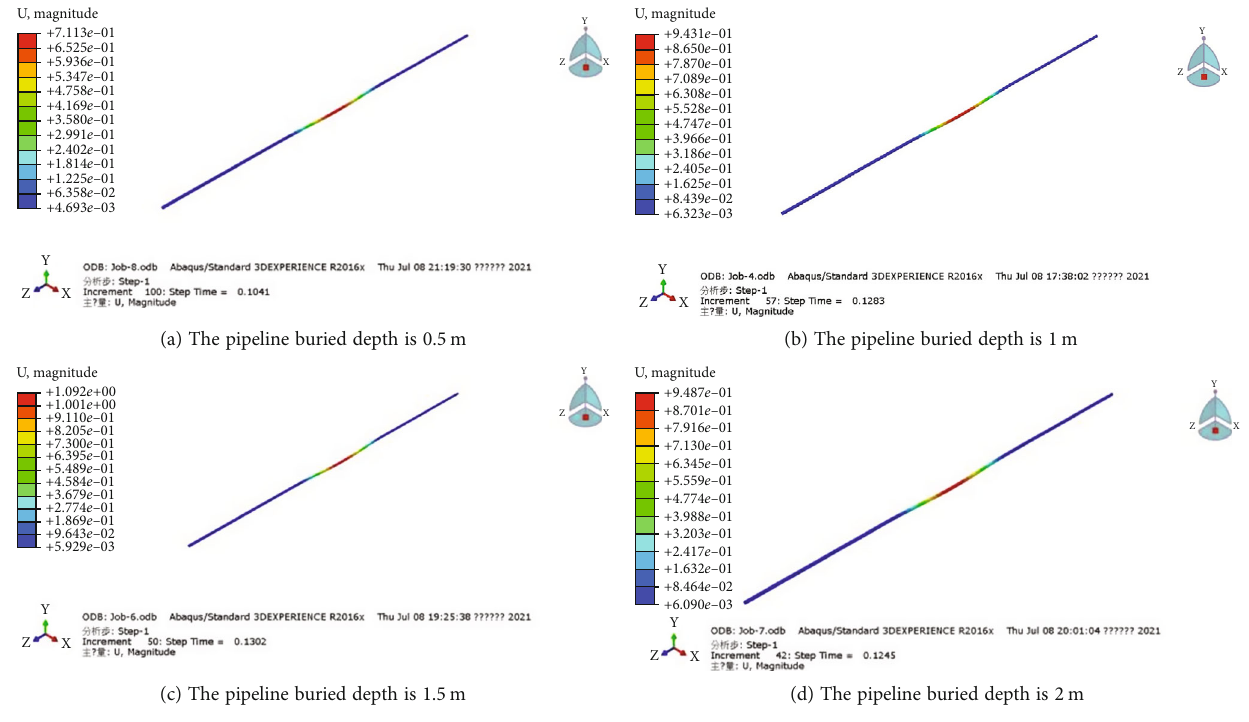
Figure 25: The pipeline ultimate deformation under di ff erent pipeline buried depths.